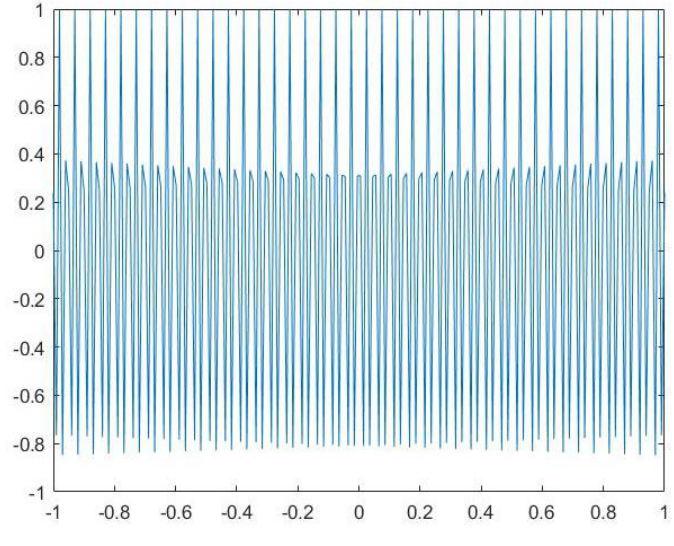
Figure 2. Example 3: graphic of k ( x ) = cos ( 250 x ) . Table 4. Example 3: numerical values of the weighted solution attained by ONM and MNM. x = −